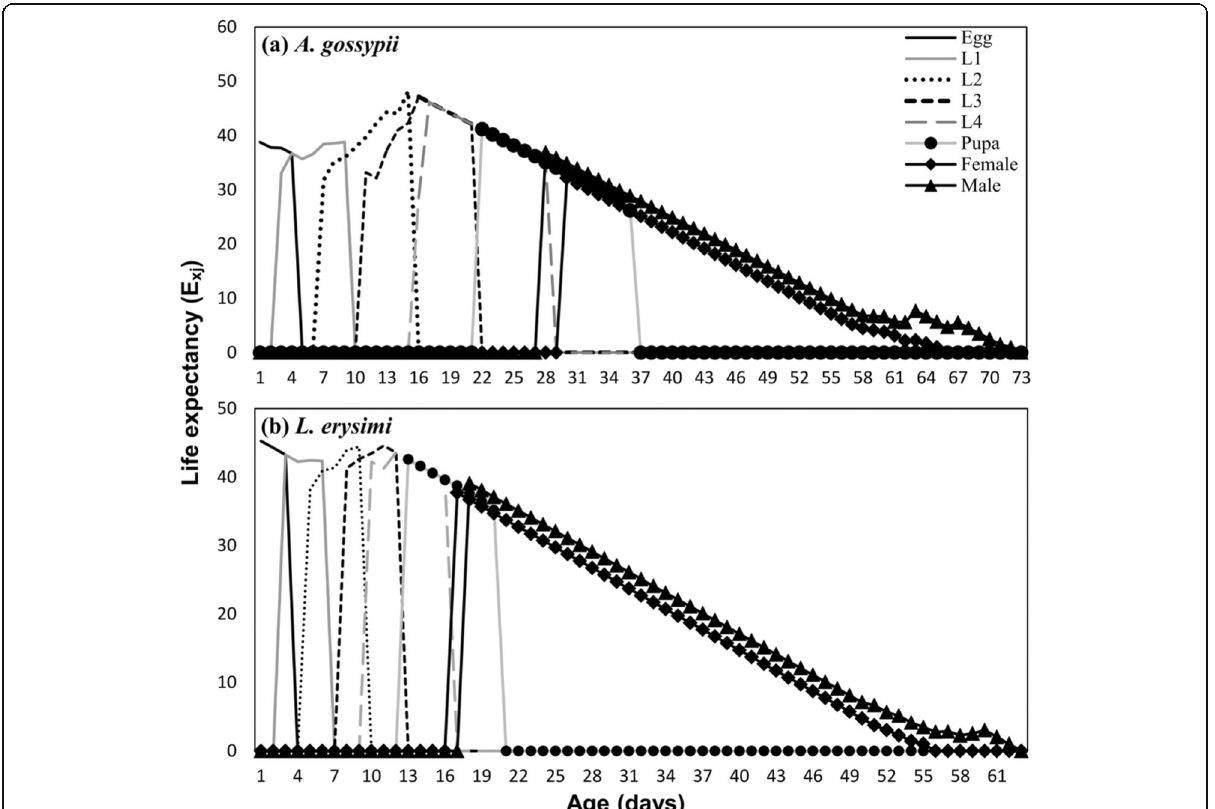
Fig. 2 Age-stage-specific life expectancy ( E xj ) of Hippodamia convergens fed on two aphid